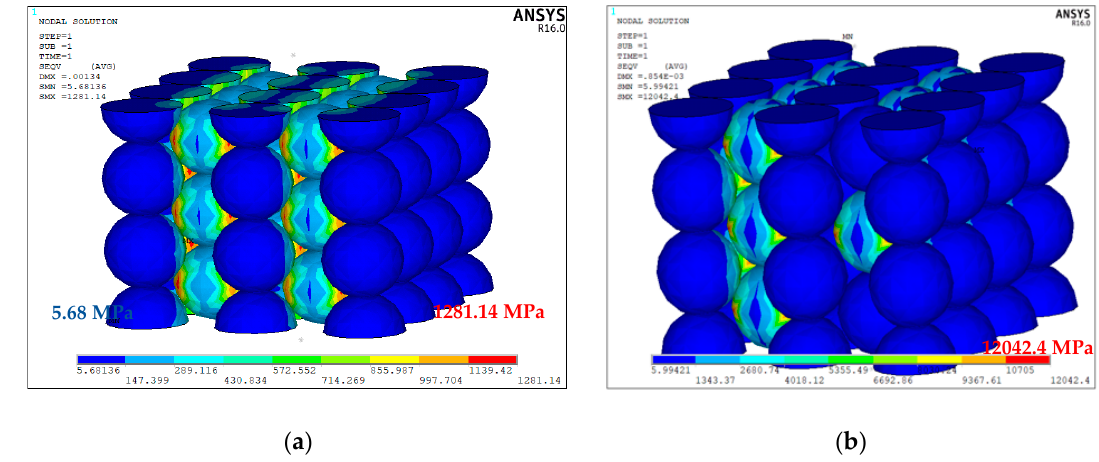
Figure 4. Representation of GO / Al composite with monolayer of GO reinforcement on Al particles: ( a ) Stress contour of Al particles without GO reinforcement; ( b ) Stress contour of GO / Al composite with Al particles coated with monolayer GO.